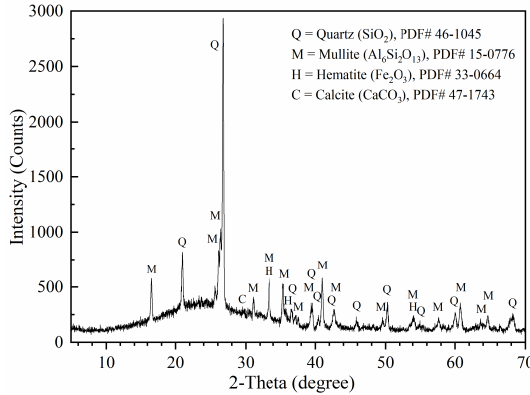
Figure 2. XRD of FA.